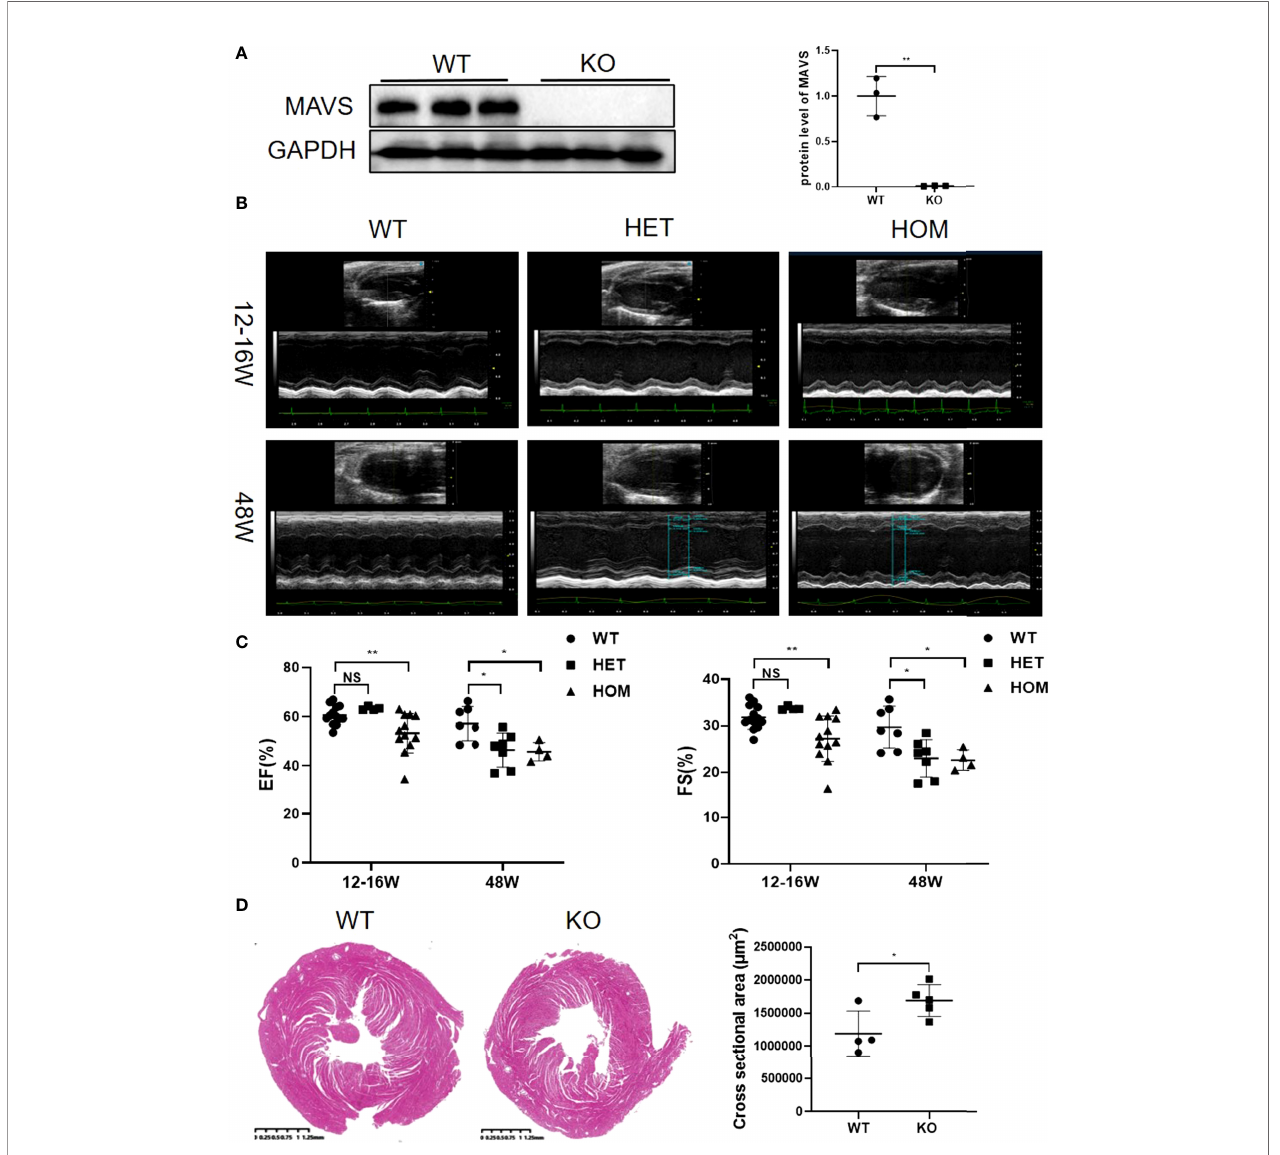
FIGURE 2 | MAVS depletion leads to left ventricular dilation and decreased systolic function in male mice. (A) . Representative western blotting analysis of MAVS in the hearts of wild-type (WT) and MAVS -/- mice. Densitometry analysis of the western blots of MAVS. (B) . Representative short-axis M-mode echocardiographic images of WT and MAVS -/- mice aged 12-16 weeks and 48 weeks. (C) . Ejection fraction and fractional shortening of mice from WT and MAVS -/- groups. (D) . Cross- sectional view of the hearts from WT and MAVS -/- mice at the papillary level, (scale bar=0.25mm). Cross-sectional areas of hearts from WT and MAVS -/- mice. The quantitative results are shown as means ± SEM (NS, not signi fi cant; *P < 0.05, **P <